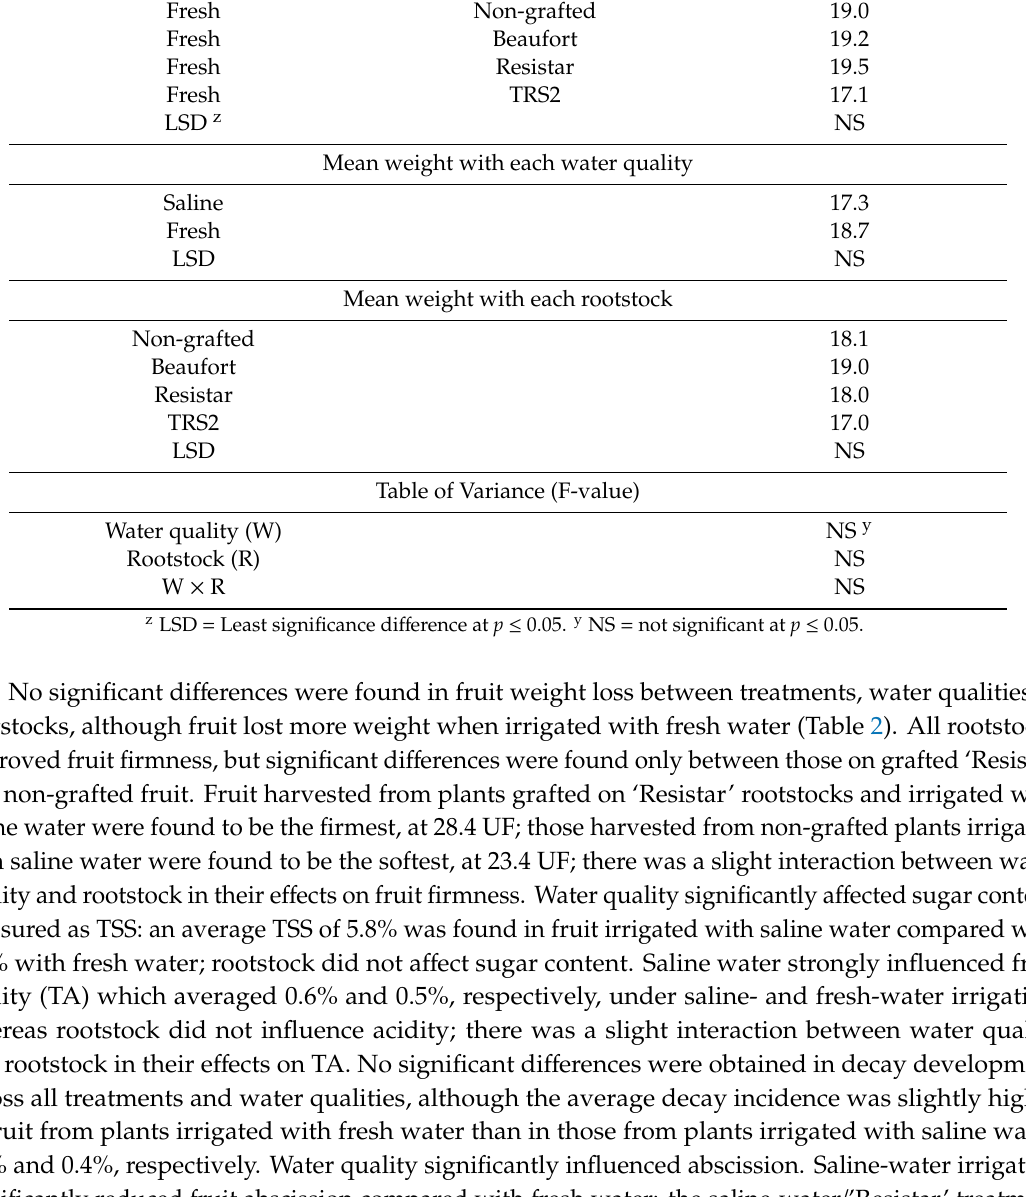
Table 1. The influence of water quality and grafting on mean fruit weights during five harvests. Results are expressed in g / fruit.